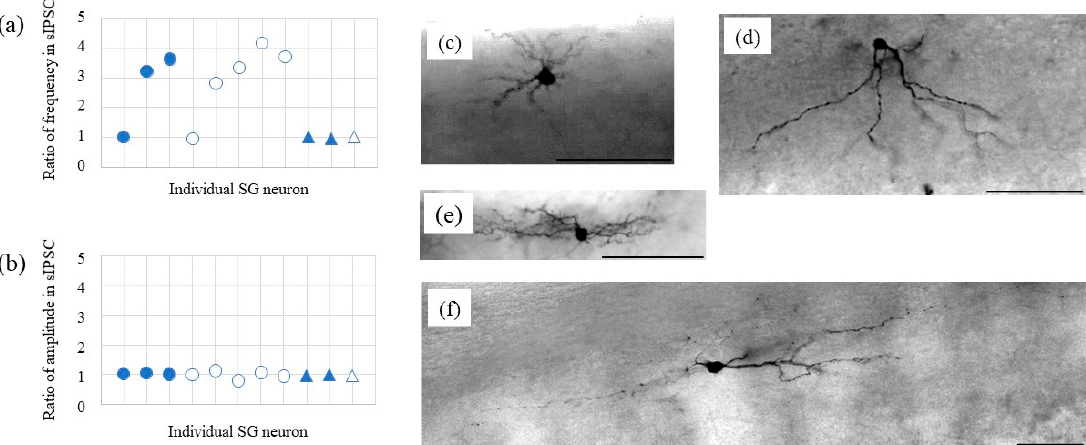
Figure 4. Responsiveness to naftopidil (100 µ M) in terms of frequency ( a ) and amplitude ( b ) of sIPSCs with stratification by morphology of SG neurons. After recording the sIPSCs, dye was injected into the SG neurons. Then, the neurons were observed under a light microscope. Closed circles, radial; open circles, vertical; closed triangles, central; and open triangle, islet. Typical images of the SG neurons are shown: radial ( c ), vertical ( d ), central ( e ), and islet ( f ). Scale bars = 100 µ